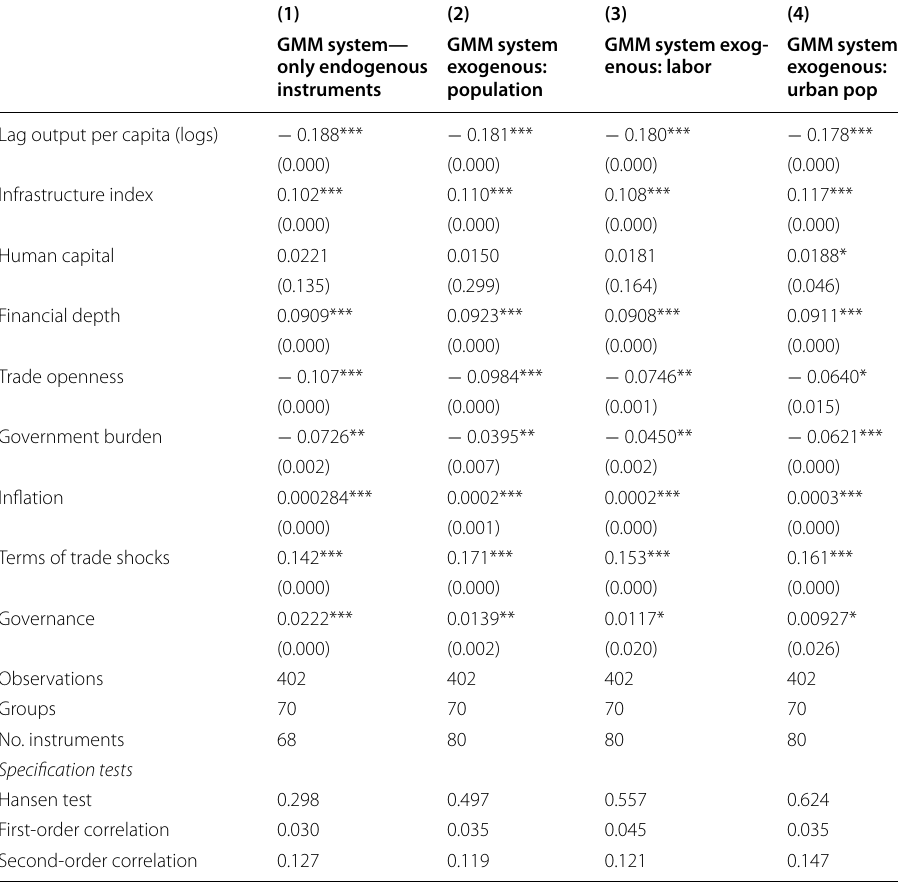
Table 3 Infrastructure stocks and economic growth: panel regression